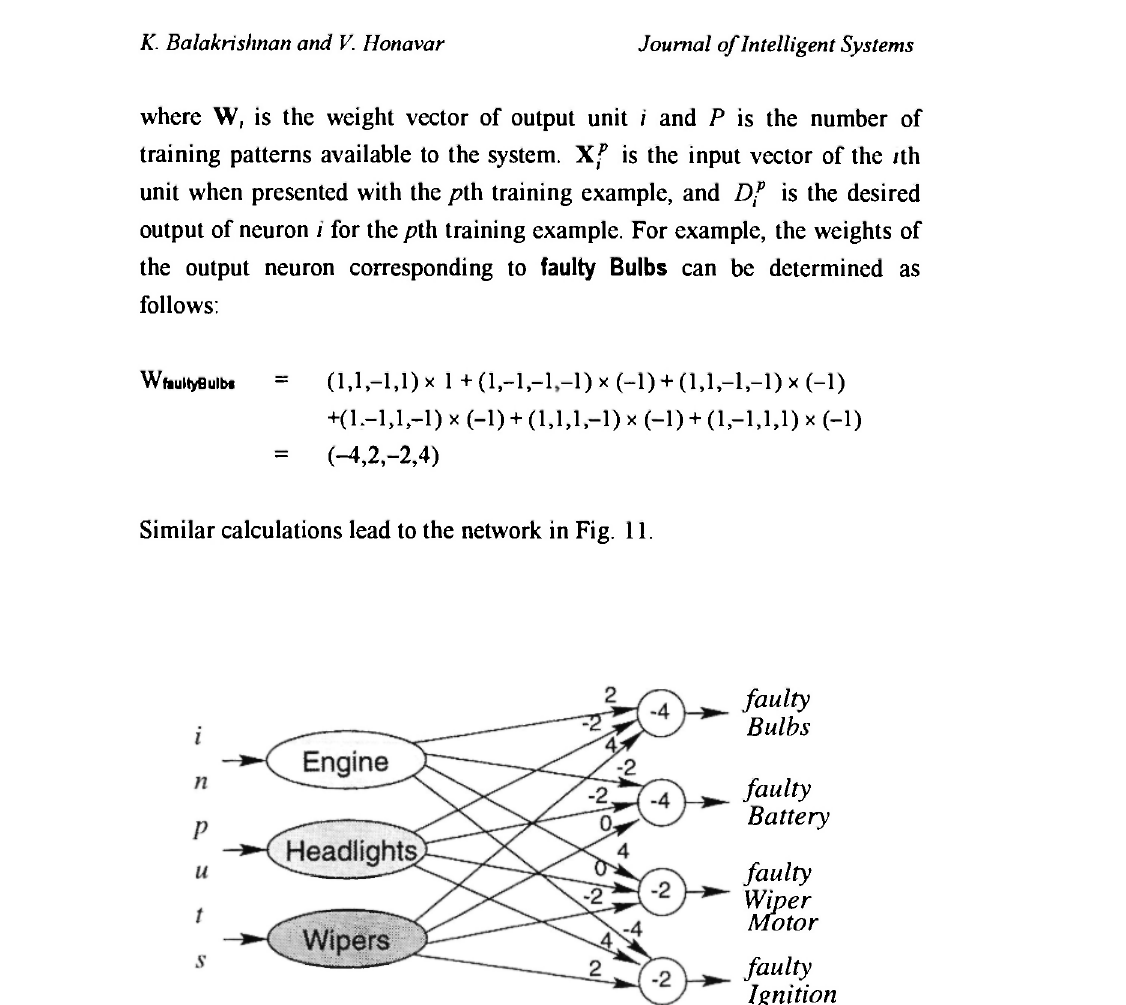
Fig. 11: A connectionist network constructed using Hebbian